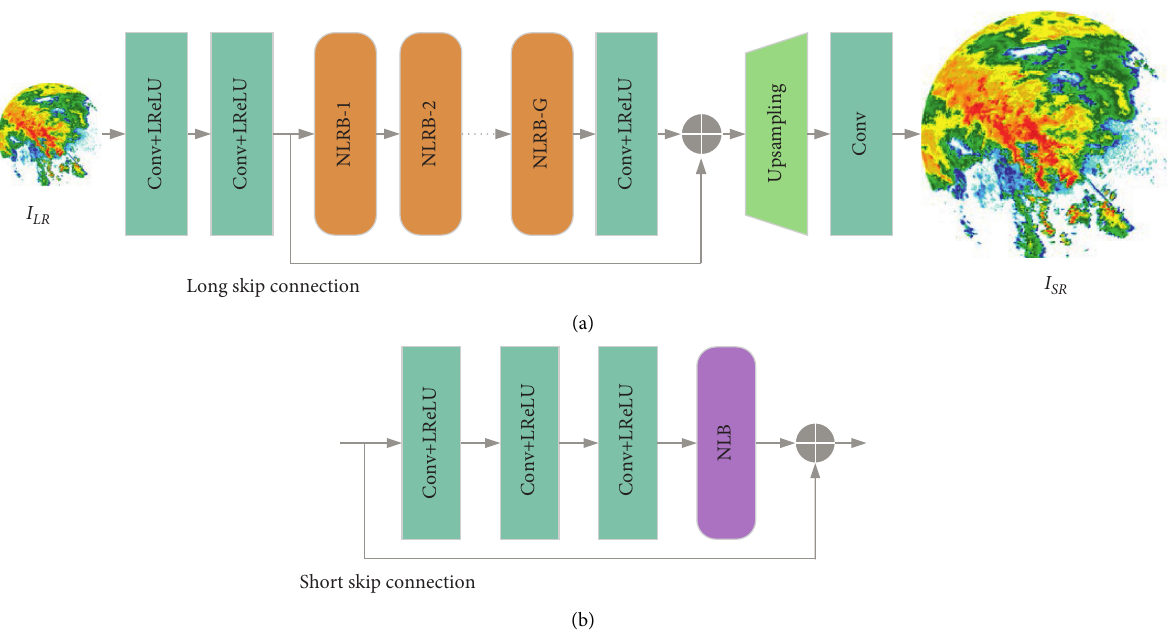
Figure 4: (a) The overall architecture of the proposed nonlocal residual network (NLRN). (b) The inner structure of nonlocal residual block